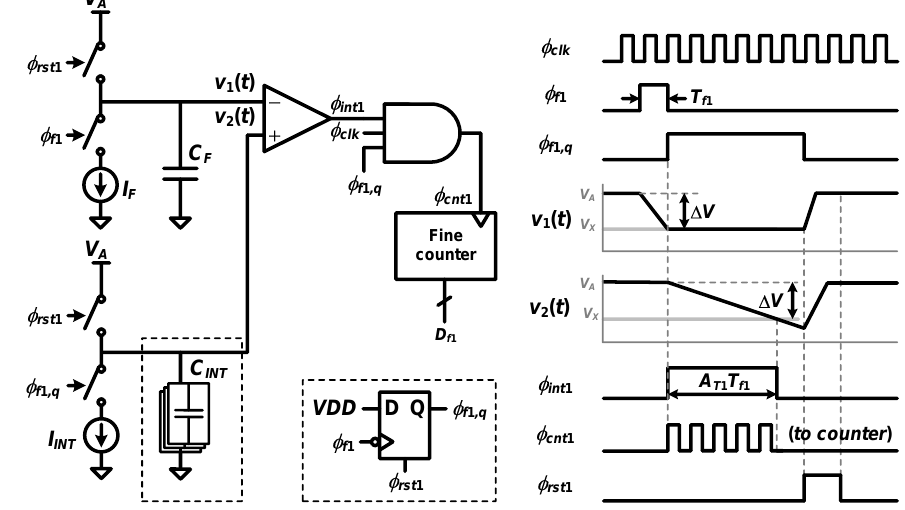
Figure 8. Block diagram and timing diagram of the reconfigurable time interpolator (reproduced from [18] with permission from the IEEE).